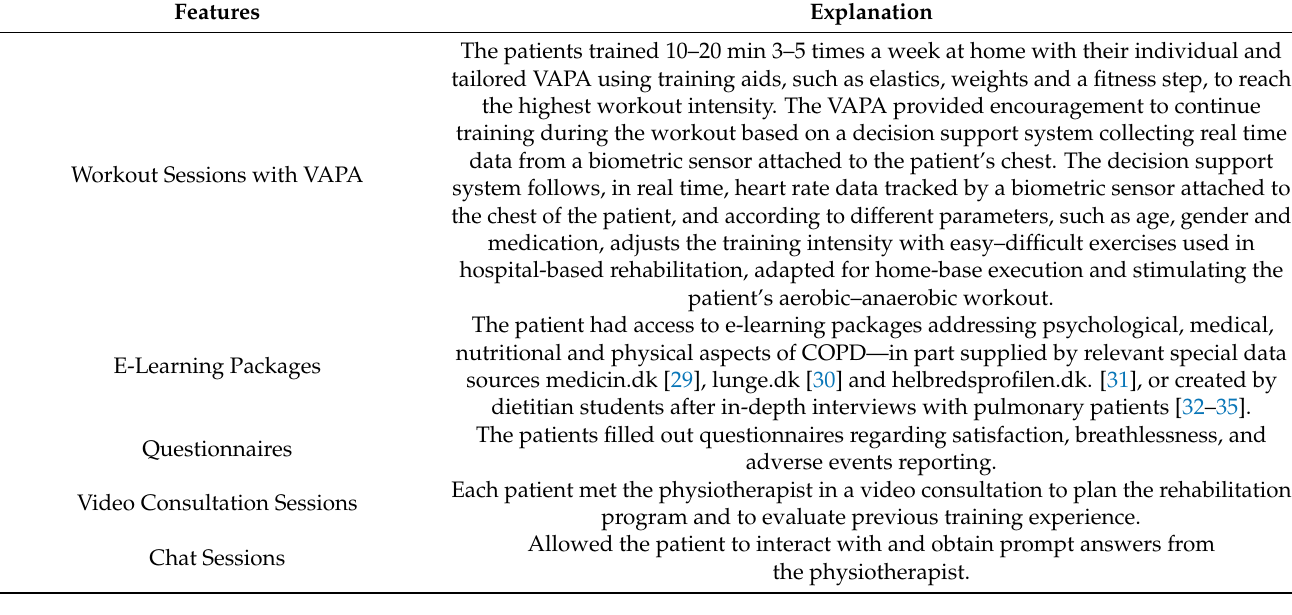
Table 1. The tele-rehabilitation program. (from Cerdan et al.). (Table 1 is taken from the paper “Tele-Rehabilitation Program in Idiopathic Pulmonary Fibrosis—A Single-Center Randomized Trial by Cerdan-de-las-heras et al. [27], used under CC BY [28]/content modified from original). Features